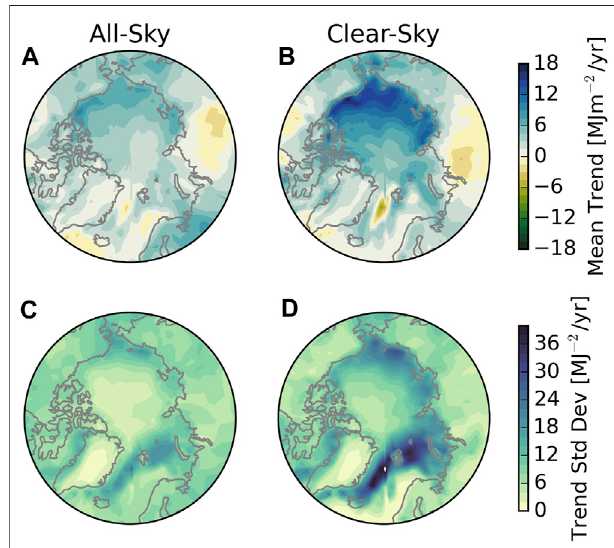
FIGURE 1 | CMIP6 mean ensemble accumulated SW (SW acc ) trends (A , B) and ensemble standard deviations (C , D) for all-sky (A , C) and clear-sky (B , D) conditions. SW acc is the total net SW energy absorbed over the melt season ( Eq. 6 ). SW fl uxes are interpolated onto the same 2.5 o x2.5 o grid as CERES in ArORIS. The models included are listed in Table 2 . Results from individual models are shown in the Supplementary Material .